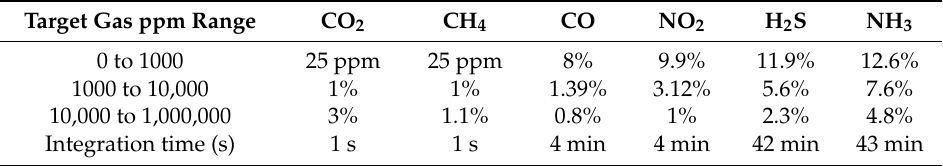
Table 4. Accuracy of gas measurements in ± percentages of the measured value or ± ppm of measured ppm—for gases of interest and total measurement integration